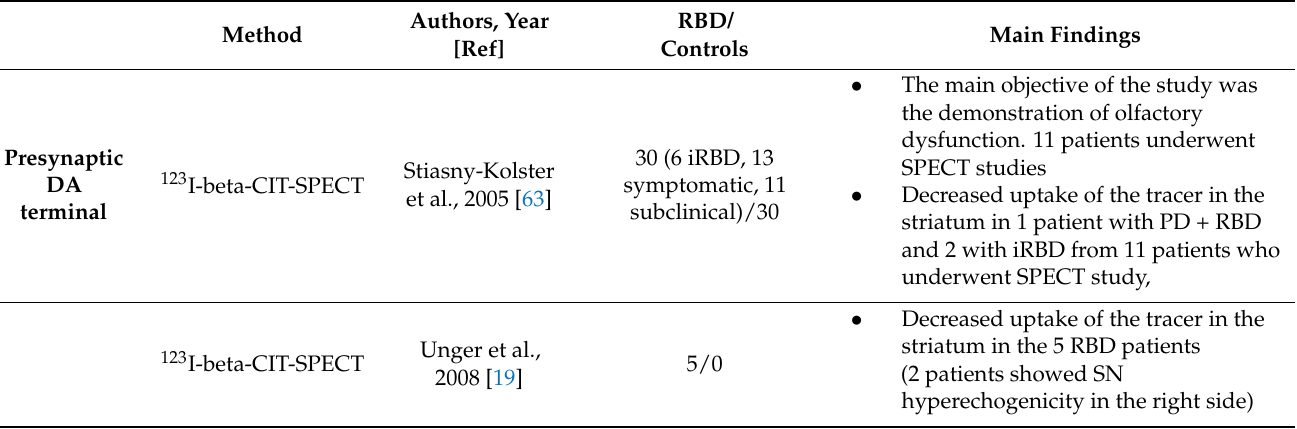
Table 1. Results of functional neuroimaging studies using dopamine, noradrenalin, serotonin, acetylcholine, inflam- matory tracers, and amyloid in patients with REM sleep behaviour disorder RBD. 11 C-CFT: 2b-carbomethoxy-3b-(4- trimethylstannylphenyl) tropane: 11[C]DTBZ [ 11 C]dihydro-tetrabenazine; 11 C-PK11195 (1-[2-chlorophenyl]-N-[1-methyl- propyl]-3-iso-quinoline; carboxamide); DASB 11